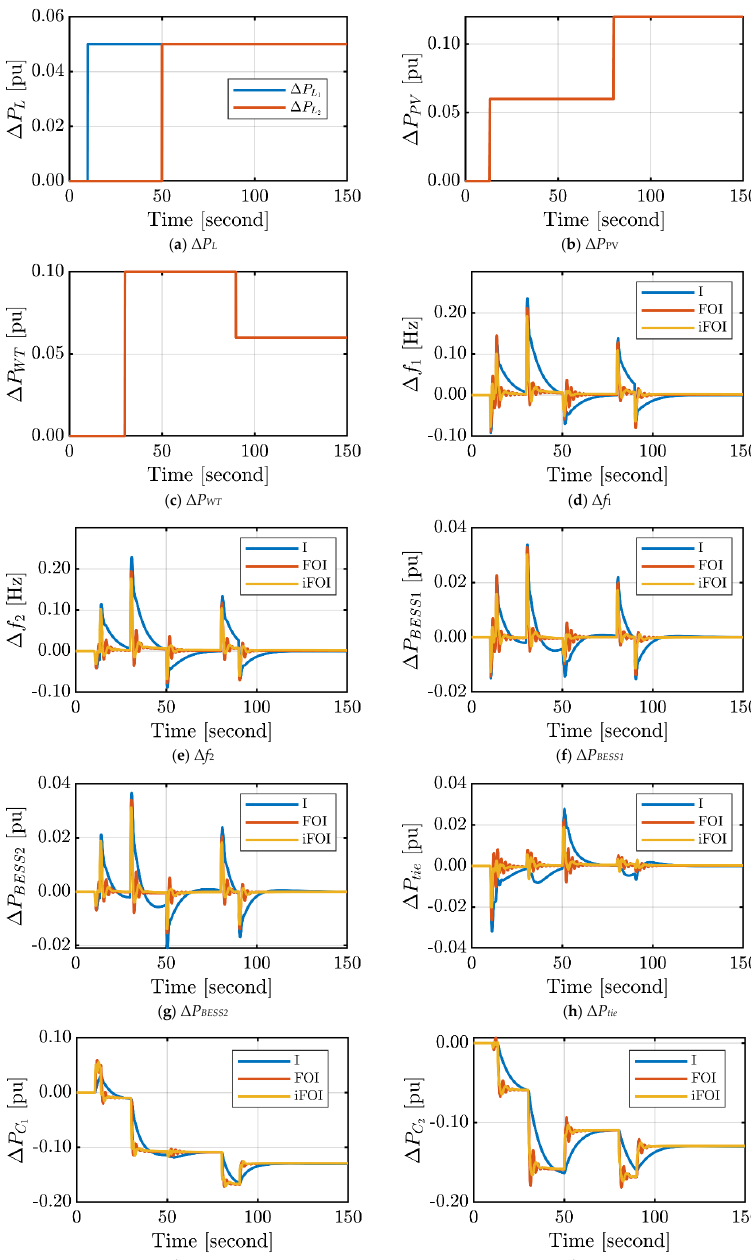
Figure 8. Dynamic response of the two ‐ area power system in case 1.